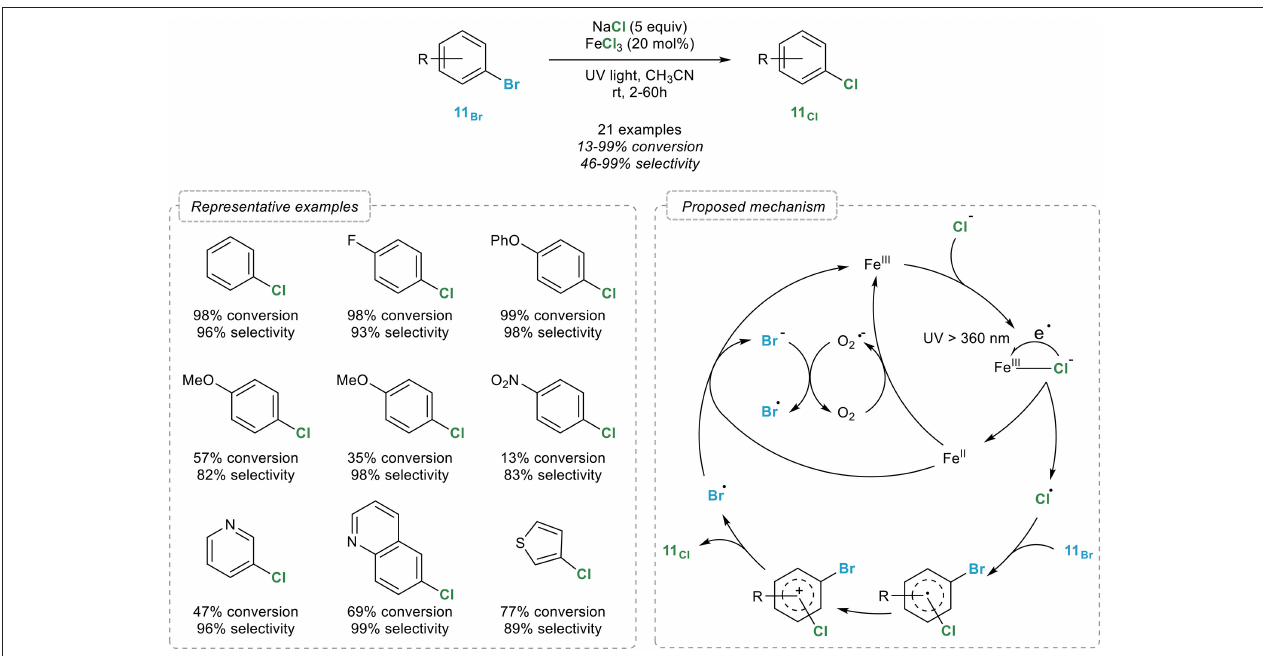
FIGURE 11 | Photo-induced aromatic retro-Finkelstein